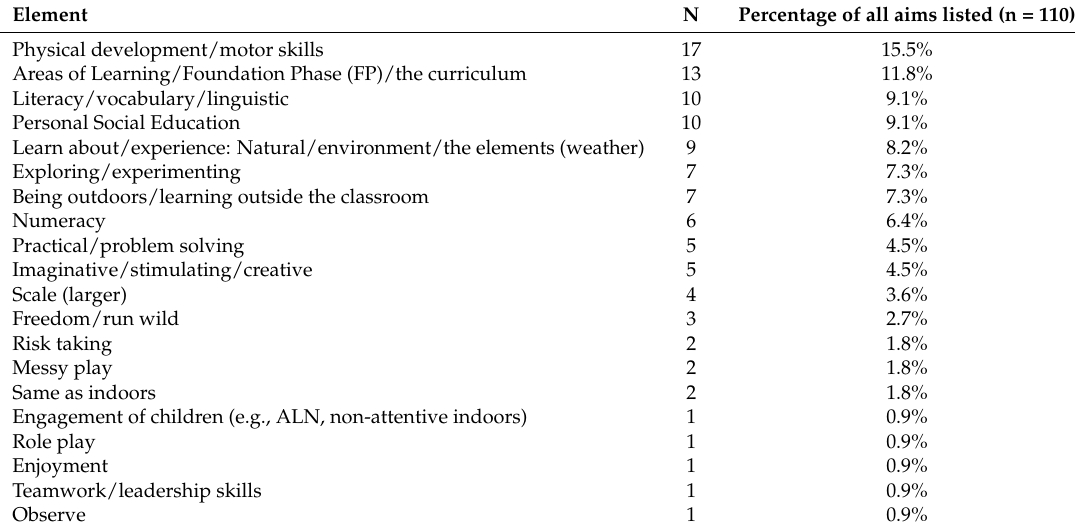
Table 3. Welsh sample. Elements arising from analysis of ‘aims’ question and associated % of coded